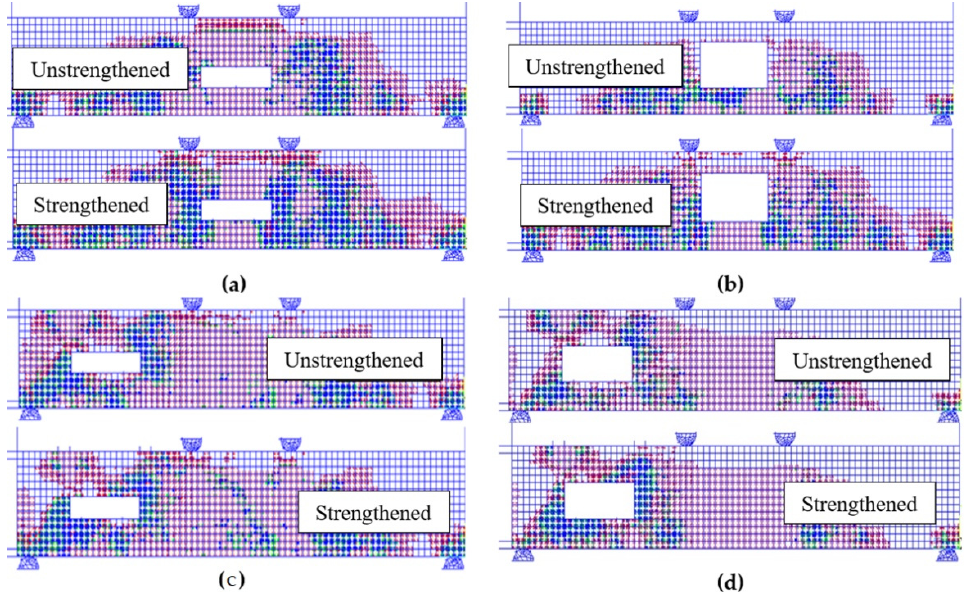
Figure 13. Numerical Crack Patterns. ( a ) tension 360 × 90 mm 2 ; ( b ) tension 360 × 210 mm 2 ; ( c ) shear 360 × 90 mm 2 ; ( d ) shear 360 × 210 mm 2